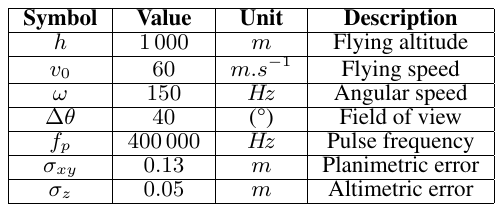
Table 1. Values of experimental parameters we used.